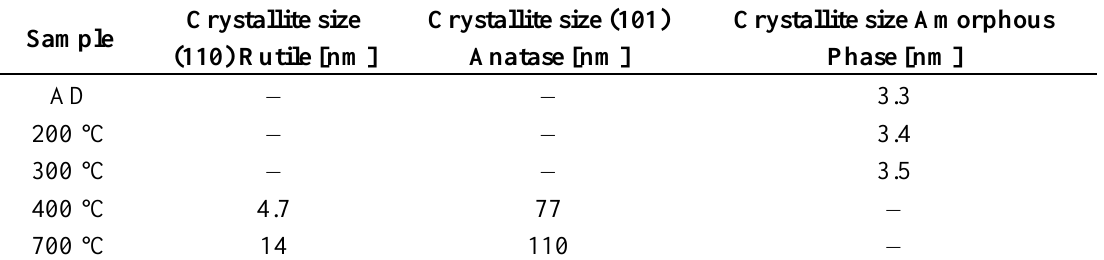
Table 1. Crystallite size calculated for titania samples characterised by XRD.